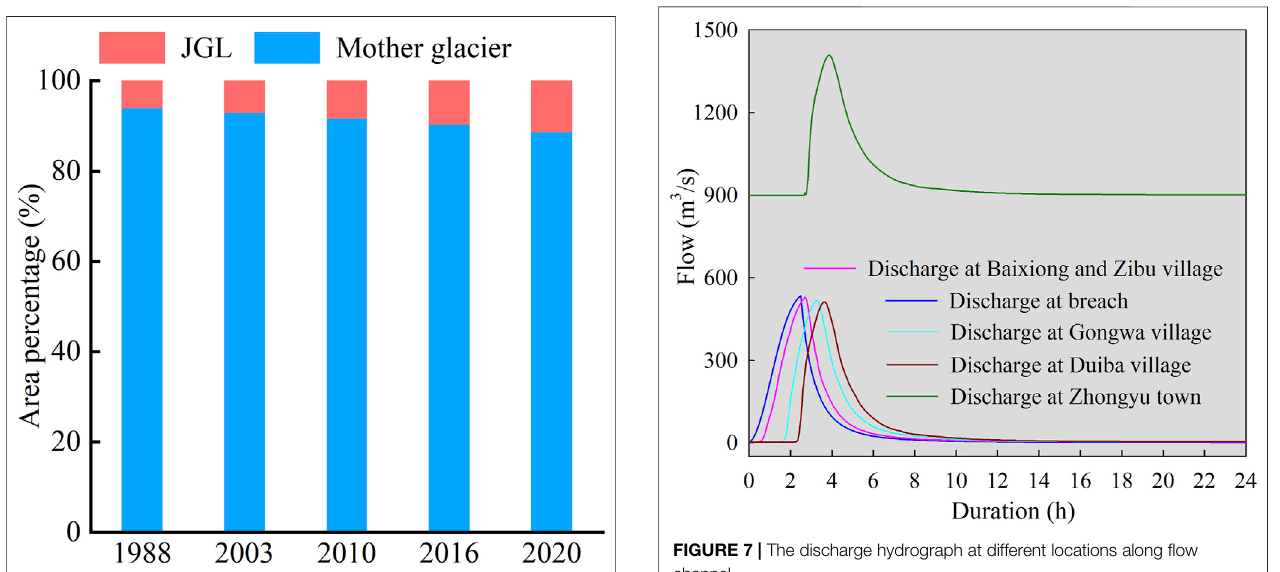
FIGURE 6 | The proportionality between JGL and ablation area of its mother glacier at different times.